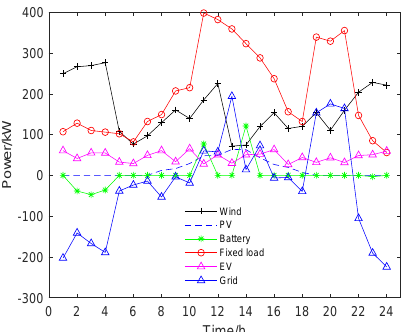
Figure 11. The output of each unit under the objective function solving by MA.